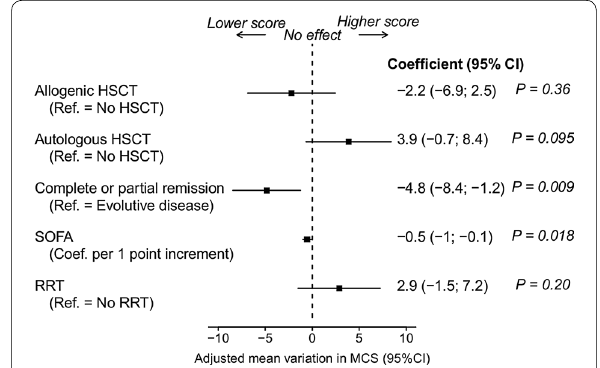
Fig. 4 Multivariate analysis: effects on mental component summary score of covariates identified by multivariate linear